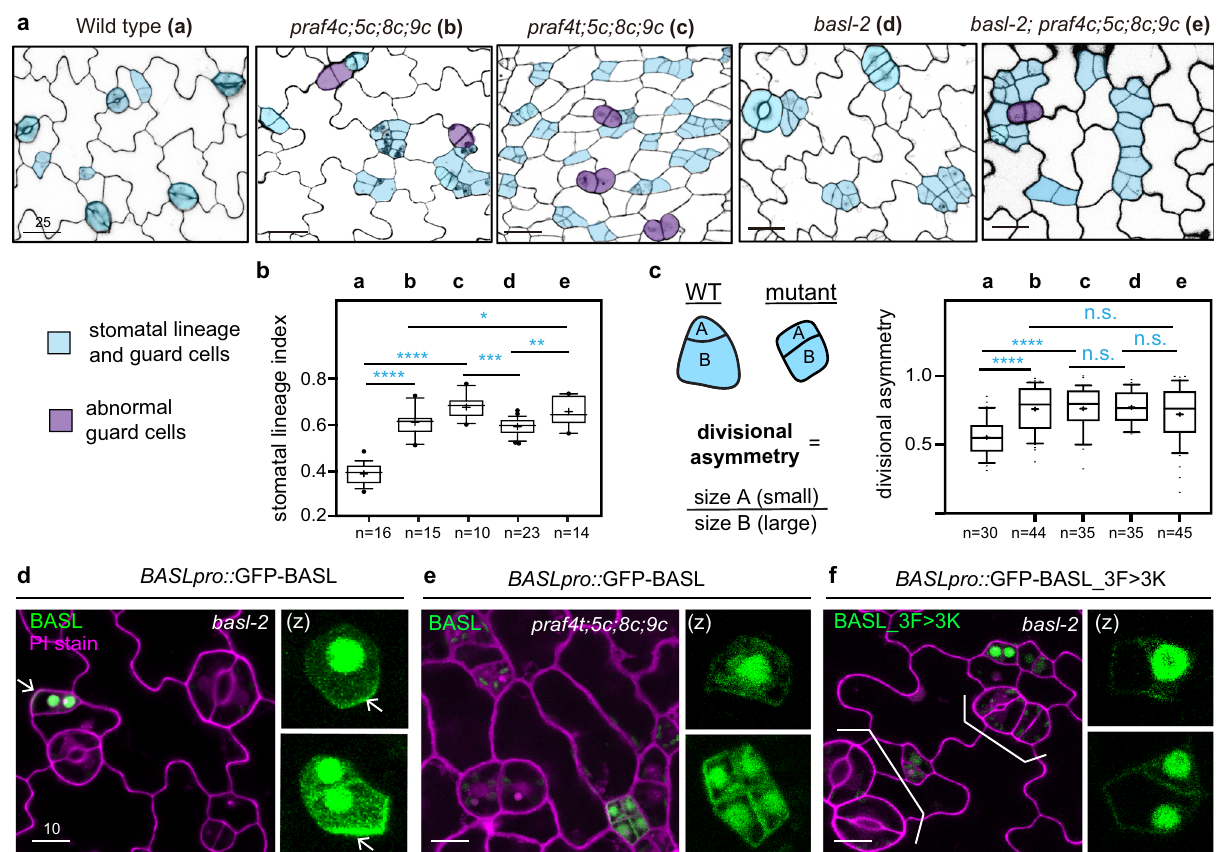
Fig. 2 PRAF proteins are required for stomatal ACD and BASL polarization. a Confocal images show abnormal stomatal division and differentiation in praf mutants. Five-day-old adaxial side cotyledon epidermis of the designated genotypes was examined. Cell outlines were visualized with Propidium Iodide (PI) staining and images were converted to black/white. Stomatal lineage cells were manually traced and highlighted by blue and abnormal guard cells were highlighted in purple. Data represent results of three independent experiments. Scale bars, 25 μ m. b – c Quanti fi cation of stomata lineage index ( b , ratio of # stomatal lineage cells/# total epidermal cells) and divisional asymmetry ( c , ratio of cell sizes) for the genotypes shown in ( a ). Box plots show fi rst and third quartile (box), median (line) and mean (cross). The parameters are applicable to all quanti fi cation data presented as box plots in this study. n , # cotyledons counted. Student ’ s unpaired t tests were used for comparison. Two-sided P values are <0.0001 (for wild type vs. praf4c;5c;8c;9c and wild type vs. praf4t;5c;8c;9c ), 0.0003 (for basl-2 vs. praf4t;5c;8c;9c ), 0.0027 (for basl-2 vs. basl-2 ; praf4c;5c;8c;9c ), and 0.0489 (for praf4c;5c;8c;9c vs. basl-2